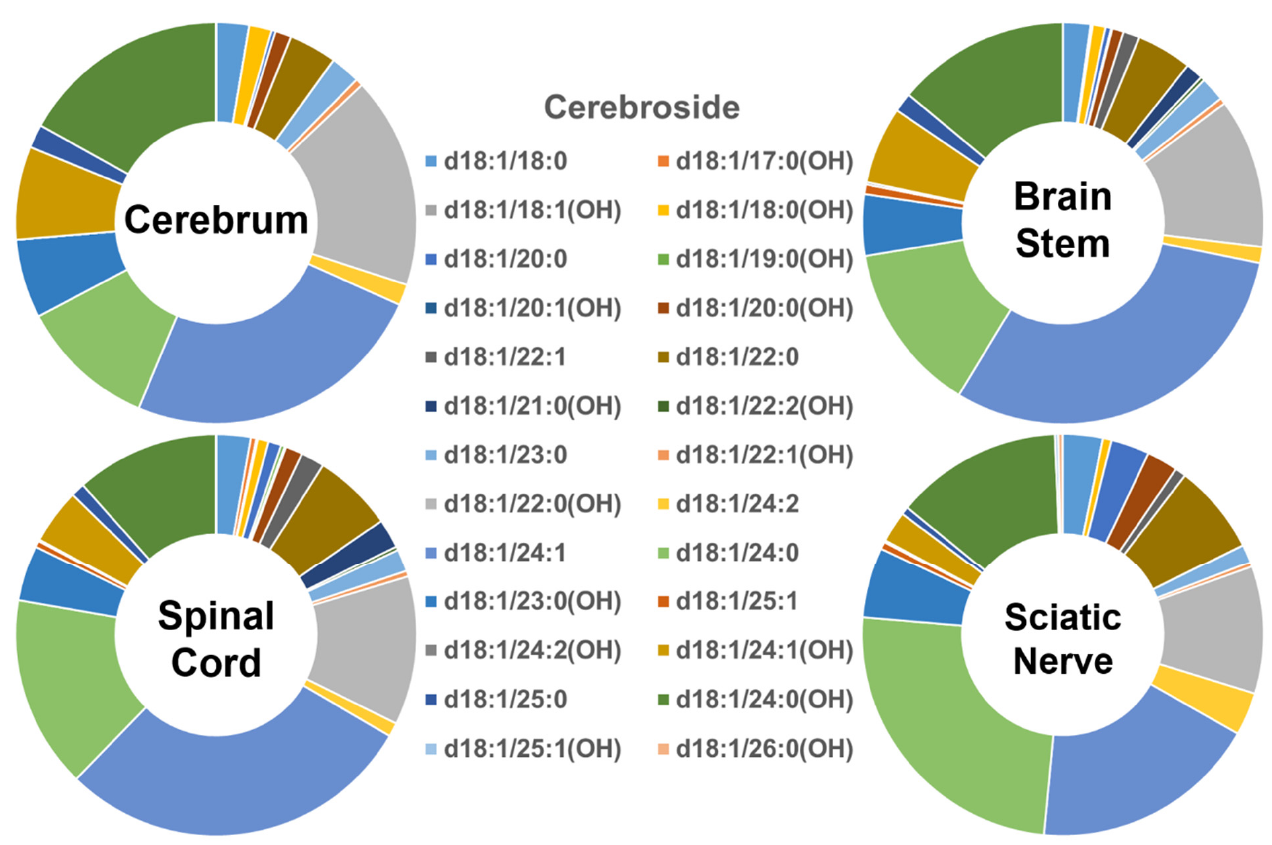
Figure 3. Comparison of cerebroside molecular species profiles in cerebrum, brain stem, spinal cord, and sciatic nerve tissues from 2 mo-old mice. Levels of individual cerebroside molecular species were assessed via shotgun lipidomics; the relative abundance of each species compared to the total class content is displayed in the form of pie graphs (Excel).